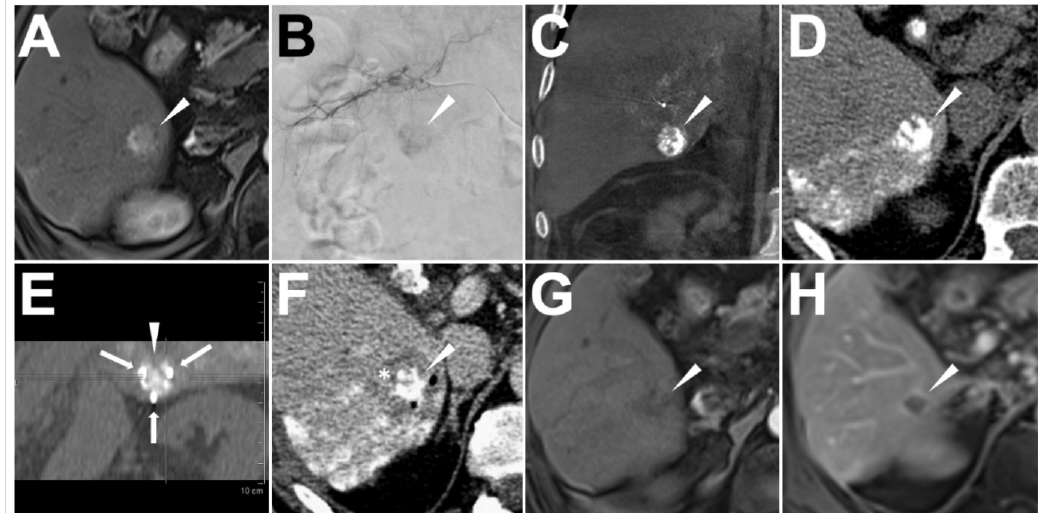
Figure 4. A patient with a de novo HCC close to the right kidney in segment VI with a size of 17.8 mm. A subcapsular target-HCC (arrowhead, LR-5, No. 10) with an increasing size of 17.8 mm at Seg VI of the liver was confirmed with definite APHE in the enhanced MRI scan ( A ). In the ethiodized oil tumor marking procedure, a clear opacity (arrowhead) of the target-HCC was found in the subsegmental angiography ( B ). After slowly injecting 1.3 mL Lipiodol for the marking, the cone-beam CT showed a completely local Lipiodol accumulation in the target-HCC (arrowhead) (coronal axis, ( C )). One day later, IRE was performed. In the post-marking CT, the target-HCC (arrowhead) could be clearly defined as complete visualization ( D ). With three electrodes (arrow) putting in a triangle configuration around the target-HCC (arrowhead) with tip exposures of 2.0 cm and a mean electrode pair distance of 1.5 cm ( E ), three (3) IRE bursts with a total of 270 pulses were applied with an average current of 43.6 A. The post-IRE enhanced CT scan showed a de-vascularized rim (*) as the ablative margin surrounding the target-HCC (arrowhead) in the portal vein phase ( F ). After a follow-up of two years, the enhanced MRI follow-up showed a persistent de-vascularized IRE zone (arrowhead) in the arterial phase ( G ) and portal phase ( H ) with shrinkage